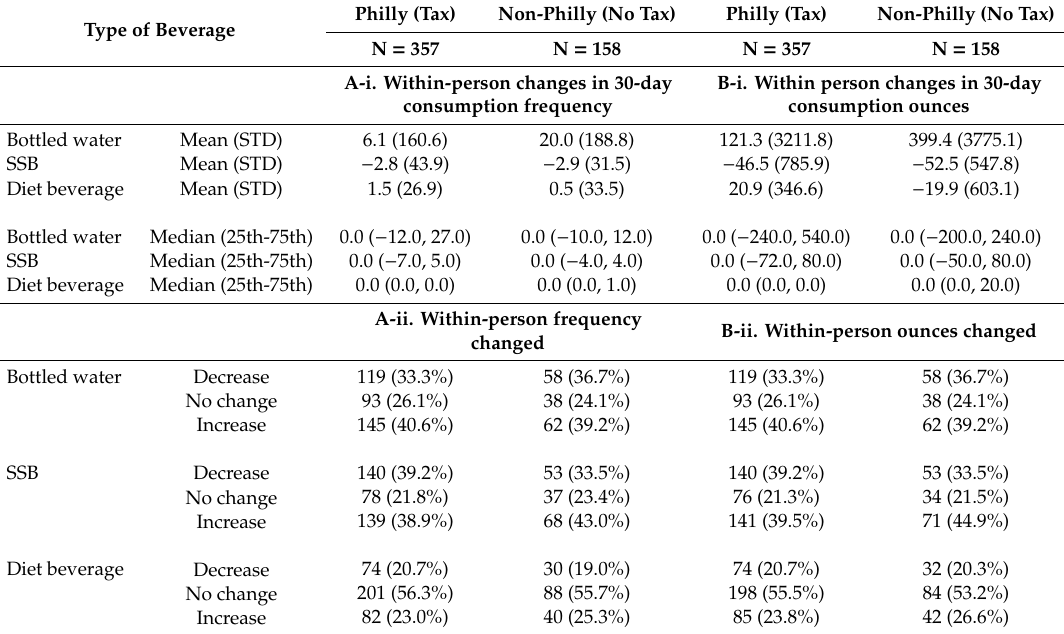
Table 3. Within-person change in bottled water, sugar-sweetened and diet beverage consumption (unadjusted for covariates), N =